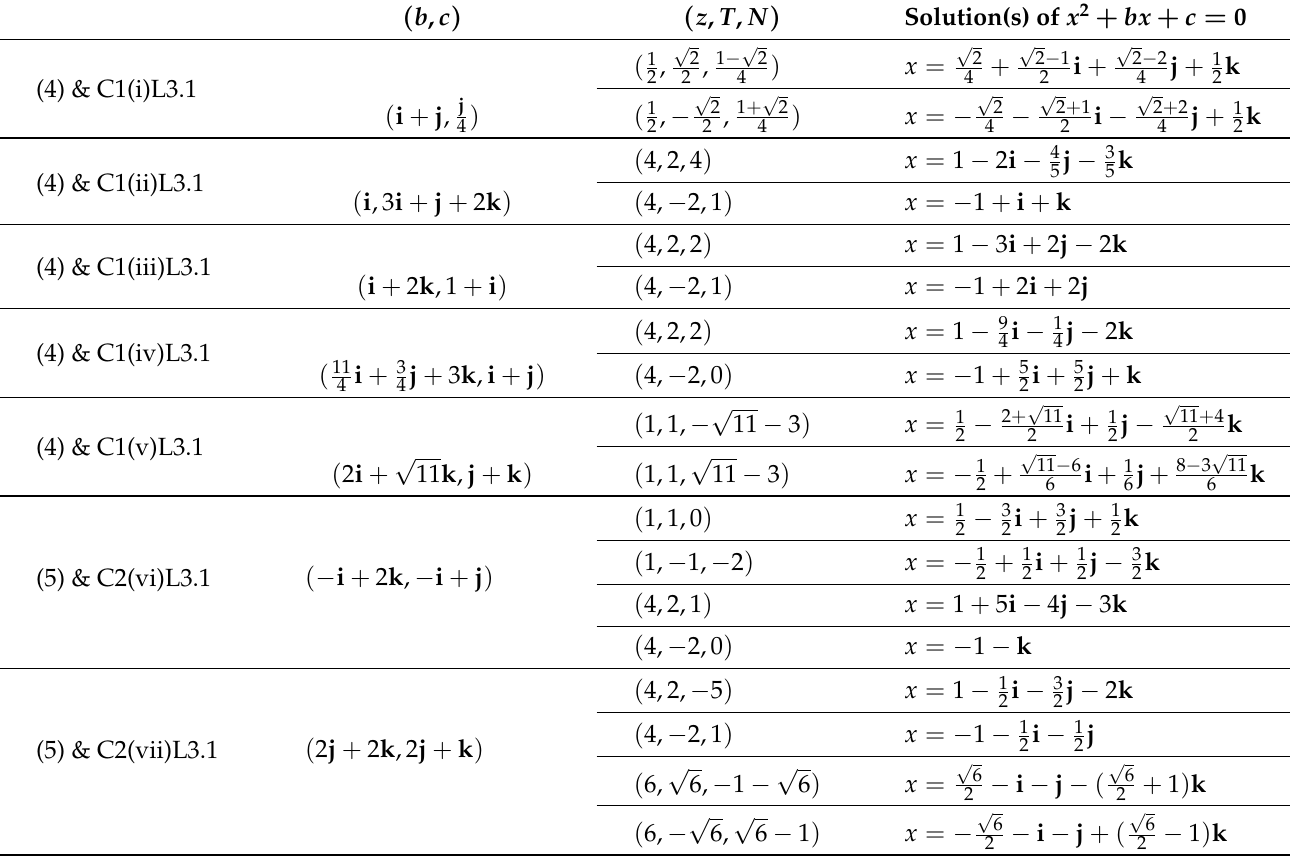
Table 3. Some examples in Theorem 2 with D (cid:54) =